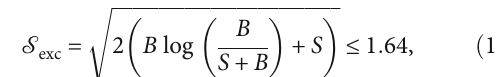
Figure 4: Potential areas of exclusion at 95% C.L. within Scenario I for a center-of-mass energy of here in dark gray, represents the one that could be possibly excluded by this analysis at 100fb -1 of integrated luminosity if no evidence of signal is found. The area below it, here in light gray, that is de fi ned by the dashed line shows the potentially excluded range at 1000 fb -1 of integrated luminosity. However, the dashed line here is not visible since it goes below masses of the lightest stau of m ~ τ shaded red area is forbidden because the decay mode H ⟶ ~ τ